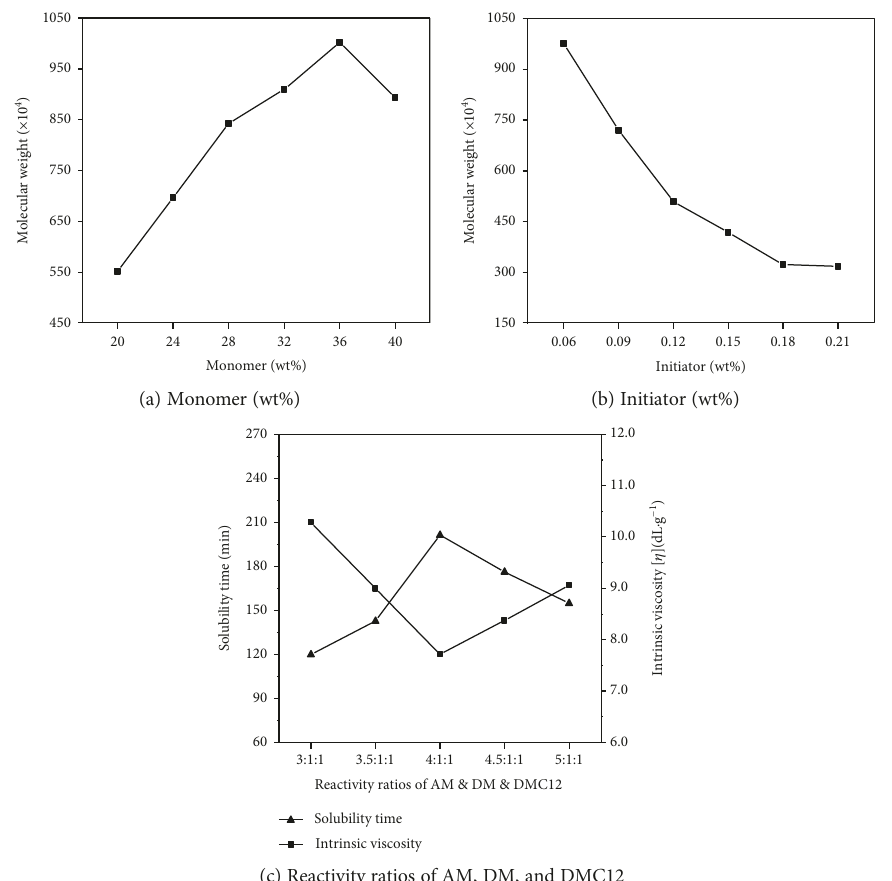
Figure 5: E ff ect of reaction conditions of P(AM-DM-DMC12).